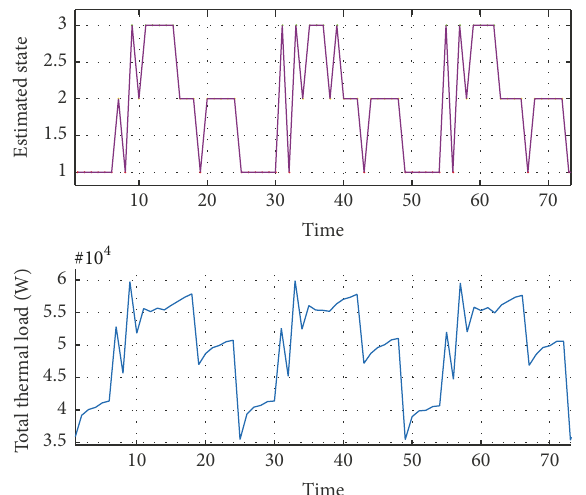
Figure 7: Discrete state estimation of the west zone versus the actual total thermal load.